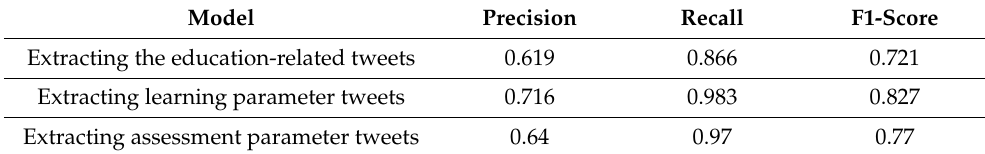
Table 3. Evaluation parameters. Model Precision Recall Extracting the education-related